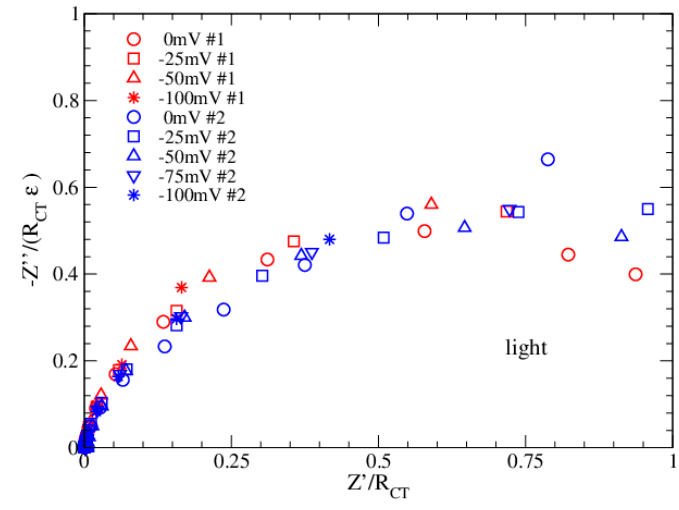
Figure 7. Normalized Nyquist plots in light for Datasets 1 and 2.